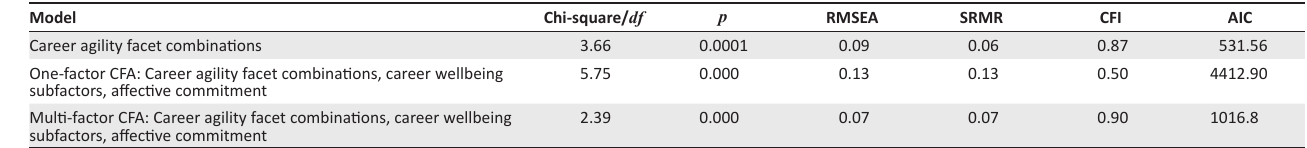
TABLE 2: Discriminant validity of the measurement model ( n = 298). Model